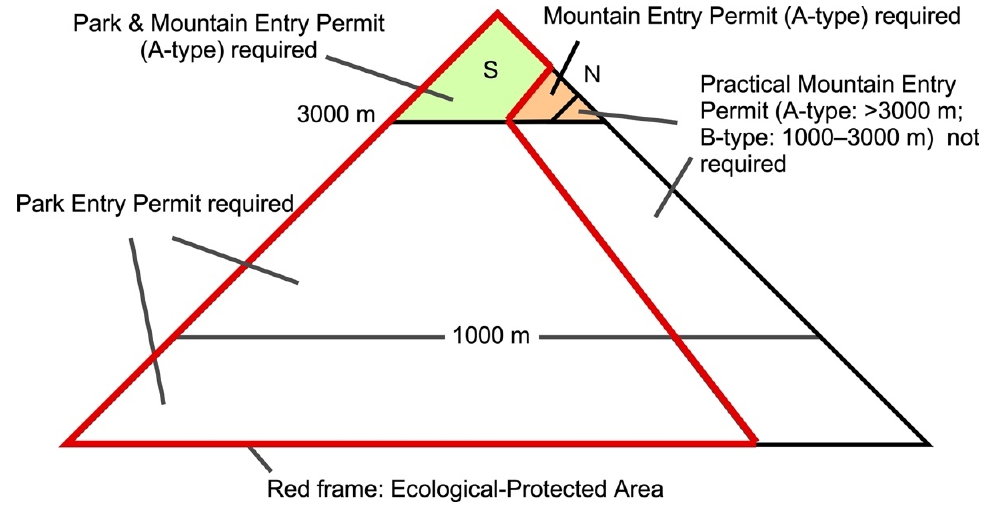
Figure 5. Application categories for entry permits to Yushan, Shei-Pa, and Taroko National Parks (prepared by the interviews with national park managers). S: ecological-protected area above 3000 m, N: scenic area above 3000 m.